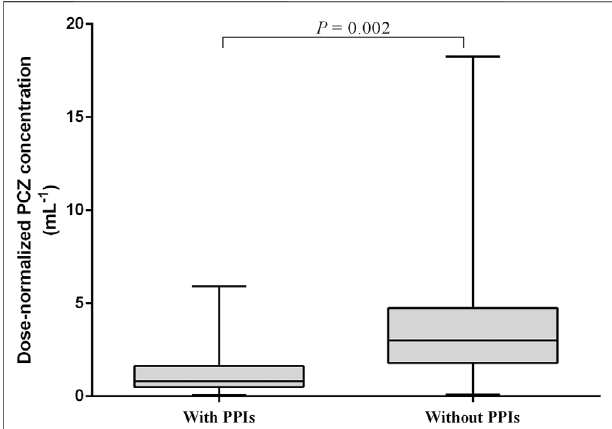
FIGURE 6 | Effect of proton pump inhibitors (PPIs) on dose-normalized PCZ C min . The graph shows boxplots with whiskers (min to max) of dose- normalized C min